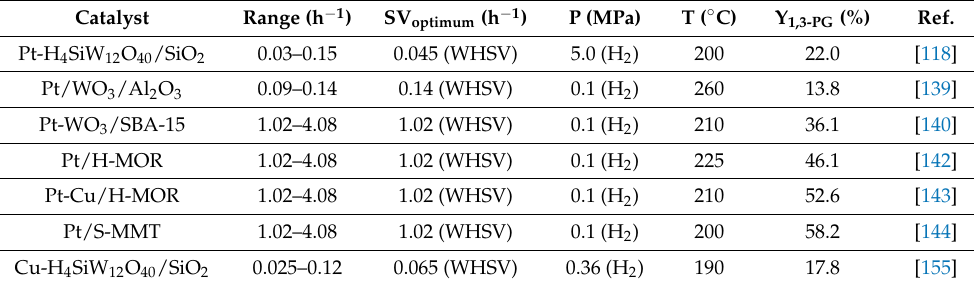
Table 15. The effect of space velocity in continuous flow